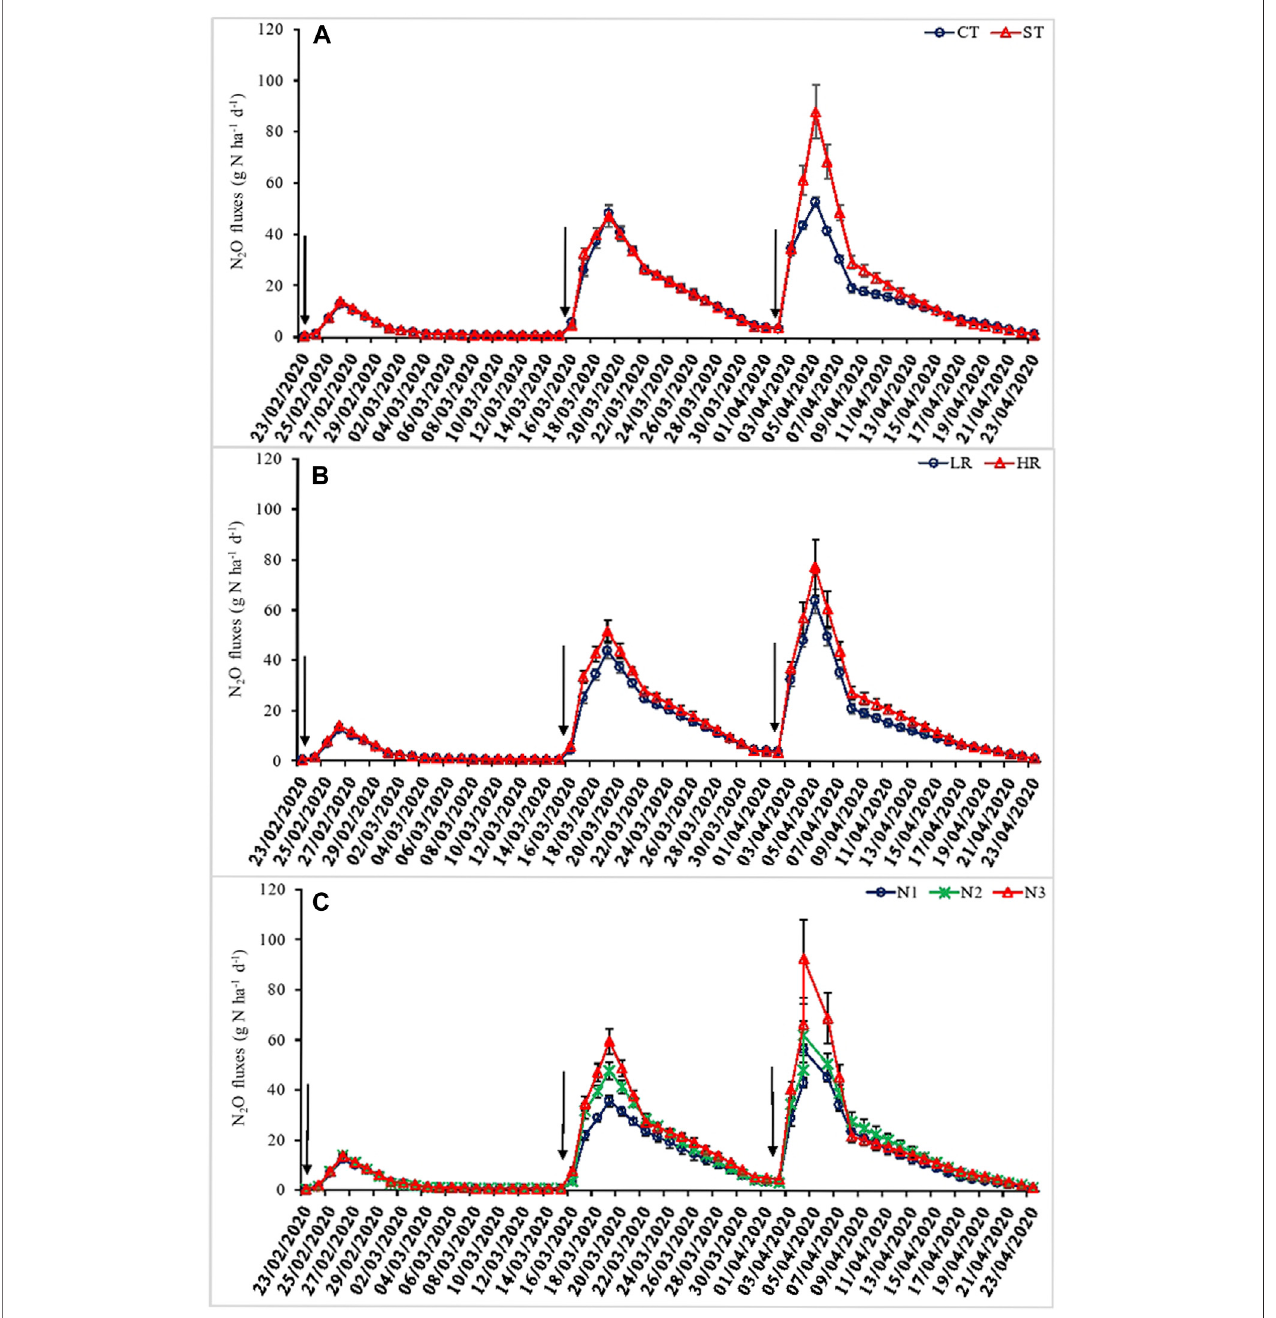
FIGURE 1 | N 2 O emissions (mean ± SE; n = 3) in (A) two tillage systems, (B) two residue levels, and (C) three N application rates over time, days after urea application, in conventional (CT) and strip (ST) tillage systems across the residue levels and N rates in Boro rice; arrow shows the day of urea application.